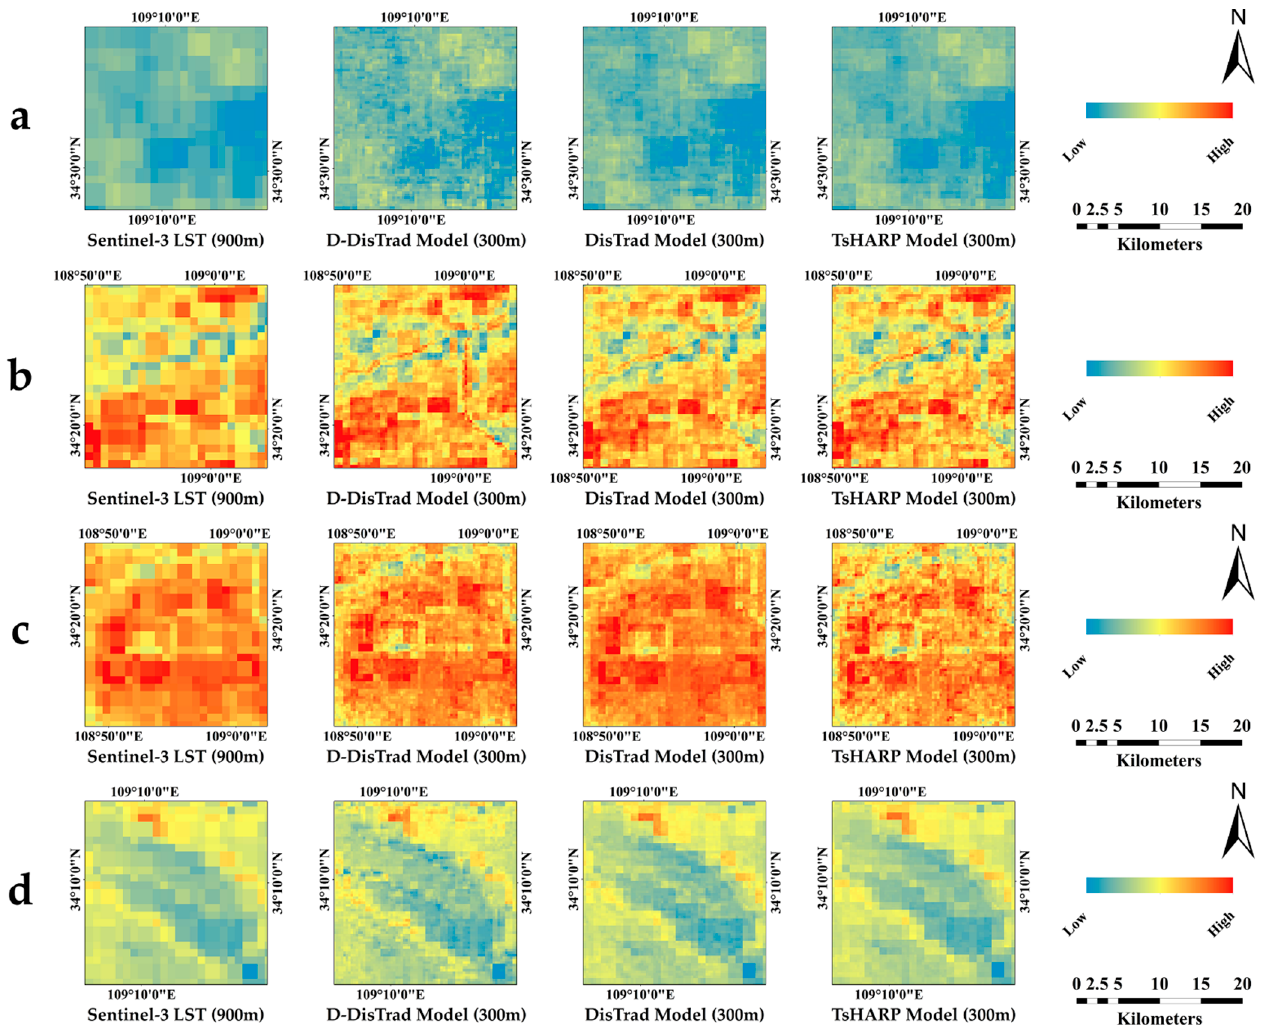
Figure 6. Each line goes from left to right, showing SLSTR LST, D-DisTrad LST, DisTrad LST, and TsHARP LST data. Areas with noticeable changes in site 3 across 4 seasons: ( a ) winter; ( b ) spring; ( c ) summer; ( d ) fall.